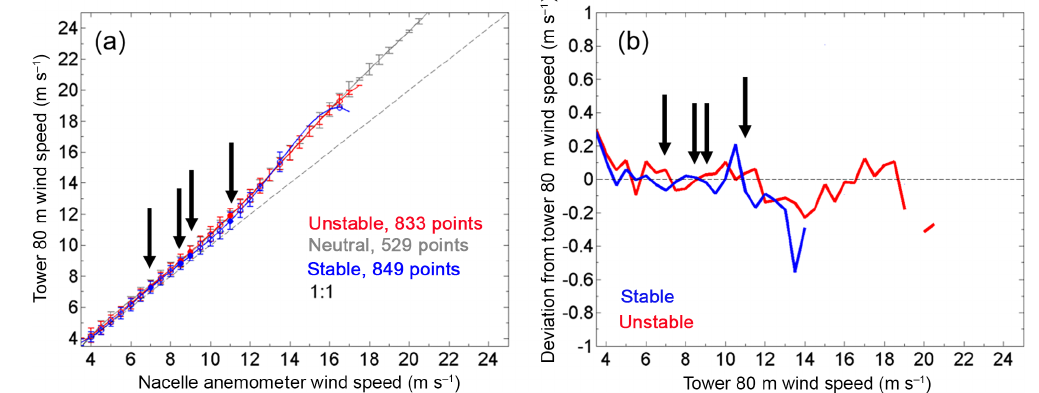
Figure 6. (a) Tower 80m NTFs calculated using fifth-order polynomial fits with stability regimes based on R B . Error bars represent ± σ of the data within the same bins as the bins with which the NTFs are calculated. Statistically distinct differences within each wind speed bin between the stability classes are determined by the Wilcoxon rank sum test with a 1% significance level and denoted by closed circles. Black arrows point towards statistically distinct bins. The figures include data filtered for tower 80m wind speeds between 3.5 and 25.0ms − 1 , 87m wind directions between 235 and 315 ◦ , and for normal turbine operation. (b) Average deviation in NTF-corrected nacelle-mounted anemometer wind speed from tower 80m wind speed is shown during stable conditions (blue) and during unstable conditions (red) versus tower 80m wind speed with stability regimes based on R B . The dashed line indicates a 0m s − 1 change.